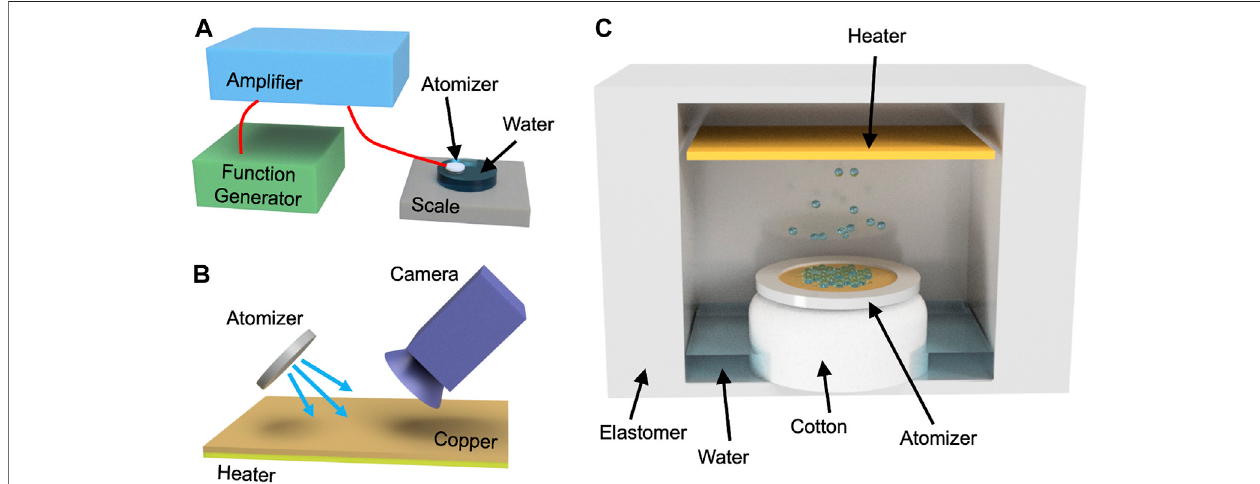
FIGURE 1 | (A) The schematic shows the setup for measuring the atomization rate. A function generator was connected to an ampli fi er, which powered the atomizer. (B) The size of the droplets on the heater surface was measured with an optical microscope. The droplets were sprayed at an angle for the camera to record. (C) Theimageshowsthecross-sectionoftheactuator.Theatomizerwas fi xedinplaceabovethecotton wick,whichabsorbedtheembeddedwater.Thedropletswere ejected to the heater, and the vapor in fl ated the structure.